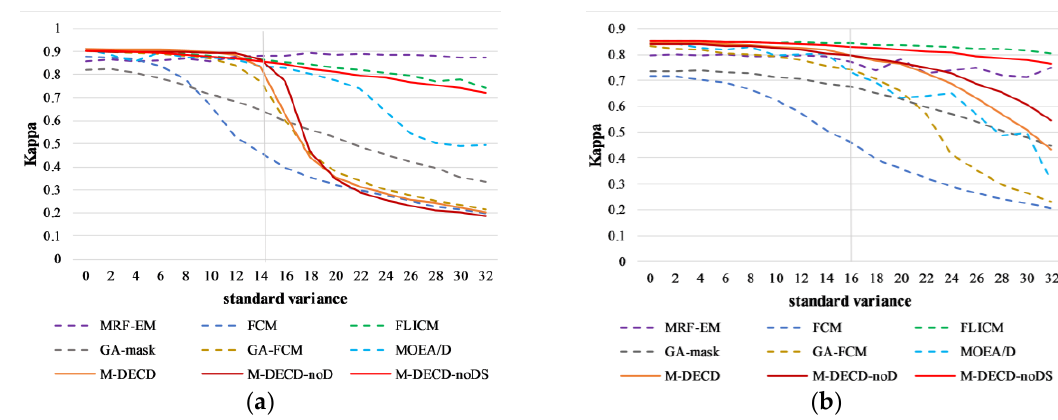
Figure 16. Gaussian noise robustness analysis of the comparison methods. ( a ) Accuracy of the Mexico dataset with respect to different noise level. ( b ) Accuracy of the Sardinia dataset with respect to different noise levels.